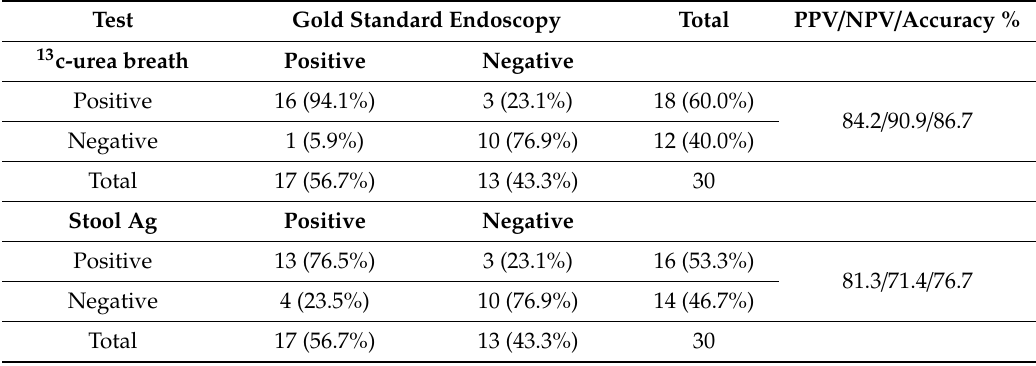
Table 3. Results using the 13 C-urea breath and stool antigen tests for the detection of h. pylori compared to endoscopy.